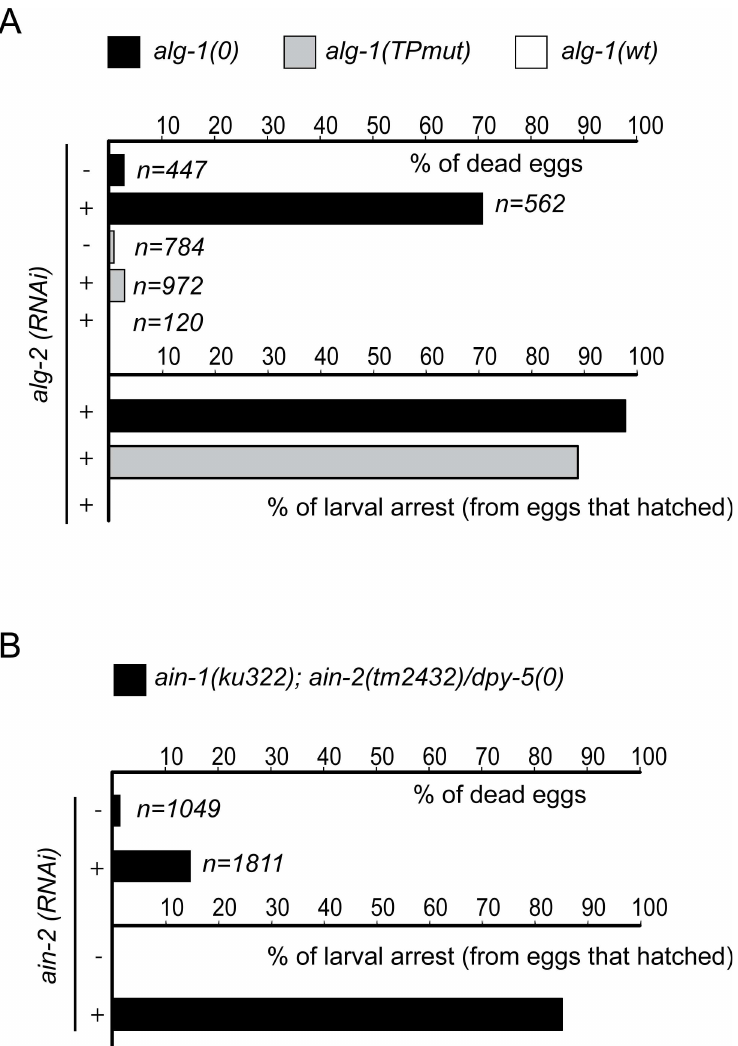
Fig 5. The GW182 proteins are not essential for microRNA-dependent silencing pathway during animal embryogenesis. (A) The alg-1 tryptophan-binding pocket mutant is not synthetic lethal with alg-2 . Early L4 staged alg-1(0) animalsalone or expressingeither alg-1wt or alg-1(TPmut) transgenic allele were picked on alg-2 (+) or control (empty L4440 vector; -) RNAi feedingplate for 24h before being separated onto new RNAi feedingplates. F1 progenyanimalswere scored for embryoniclethality and post developmental defects. The number of F1 animalsscored (n) is indicated. (B) ain-1 and ain-2 are not essential for C . elegans embryonic development. Early L4 staged ain-1(ku322); ain-2(tm2432)/dpy-5 animalswere picked on ain-2 (+) or control (empty L4440vector; -) RNAi feedingplate for 24h before being separated onto new RNAi feedingplates. F1 progenyanimalswere scored for embryonic lethality and post developmental defects. The number of F1 animalsscored (n) is